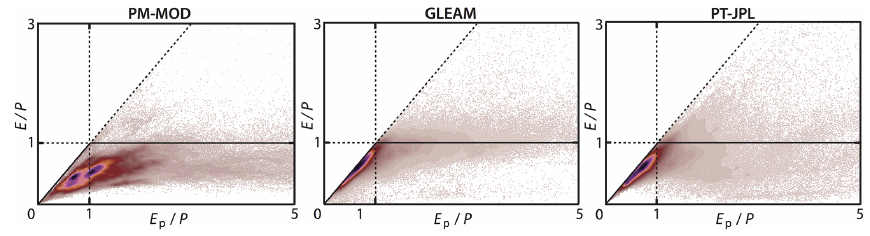
Figure 11. Budyko diagrams for the different models. Budyko curves derived for PM-MOD, GLEAM, and PT-JPL. Each point represents a different land grid cell. The horizontal axis presents the ratio of potential evaporation to precipitation ( E p /P ) and the vertical axis presents the ratio of evaporation to precipitation ( E/P ). Actual and potential evaporation estimates are derived by each of the models, while precipitation comes from GPCC v6 with gauge correction factors from Fuchs et al. (2001). Each land pixel is an independent scatter